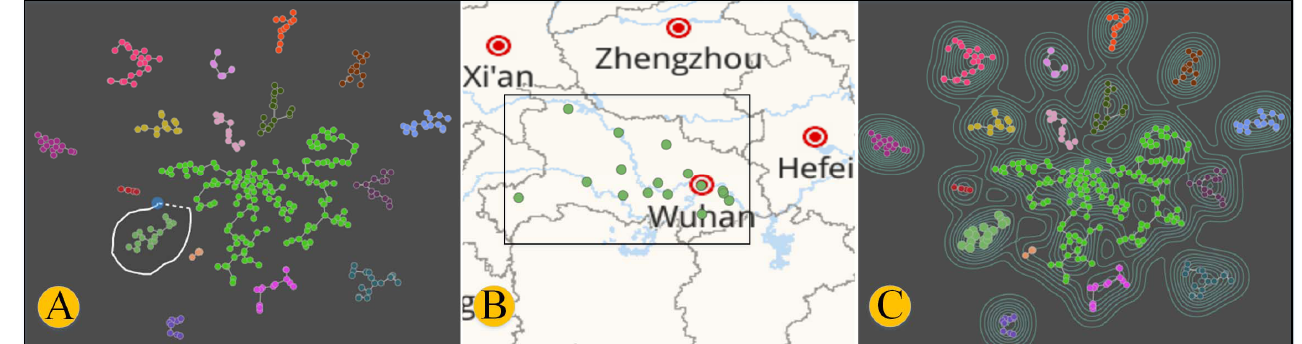
Figure 6. Interaction between the map and reduced-dimension clustering view. ( A ) Selection of relevant data using the lasso tool. ( B ) Highlighted points corresponding to selected dots in the map view. ( C ) Effect of the overlaying contour on the scatter chart.